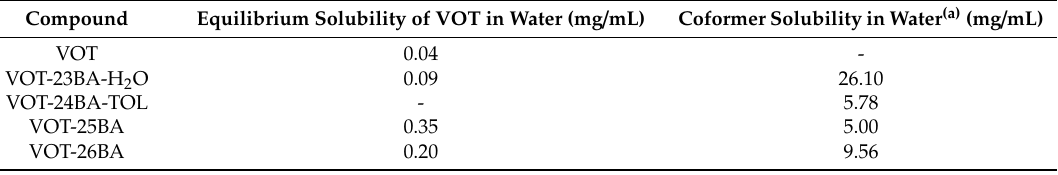
Table 3. Solubility of vortioxetine and its dihydroxybenzoic acid salts in water at 37 ◦ C. Compound